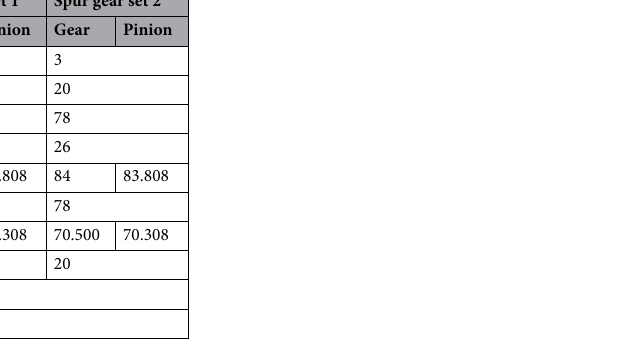
Table 3. Specification of spur gear sets 1 and 2.